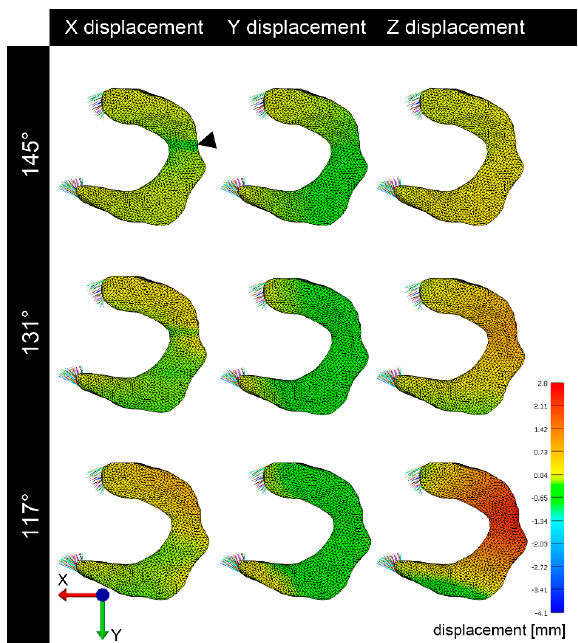
Figure 3. Translocation/deformation of the medial meniscus. Translocation of the medial meniscus in the X-axis is seen early in the simulation (145°) in particular in the attachment area of the medial collateral ligament (arrowhead). Strongest translocation in Y-axis is seen in the area of the meniscal ligament attachments. In the Z-axis, strongest translocation is seen at high flexion (117°) in the attachment area of the medial collateral ligament.